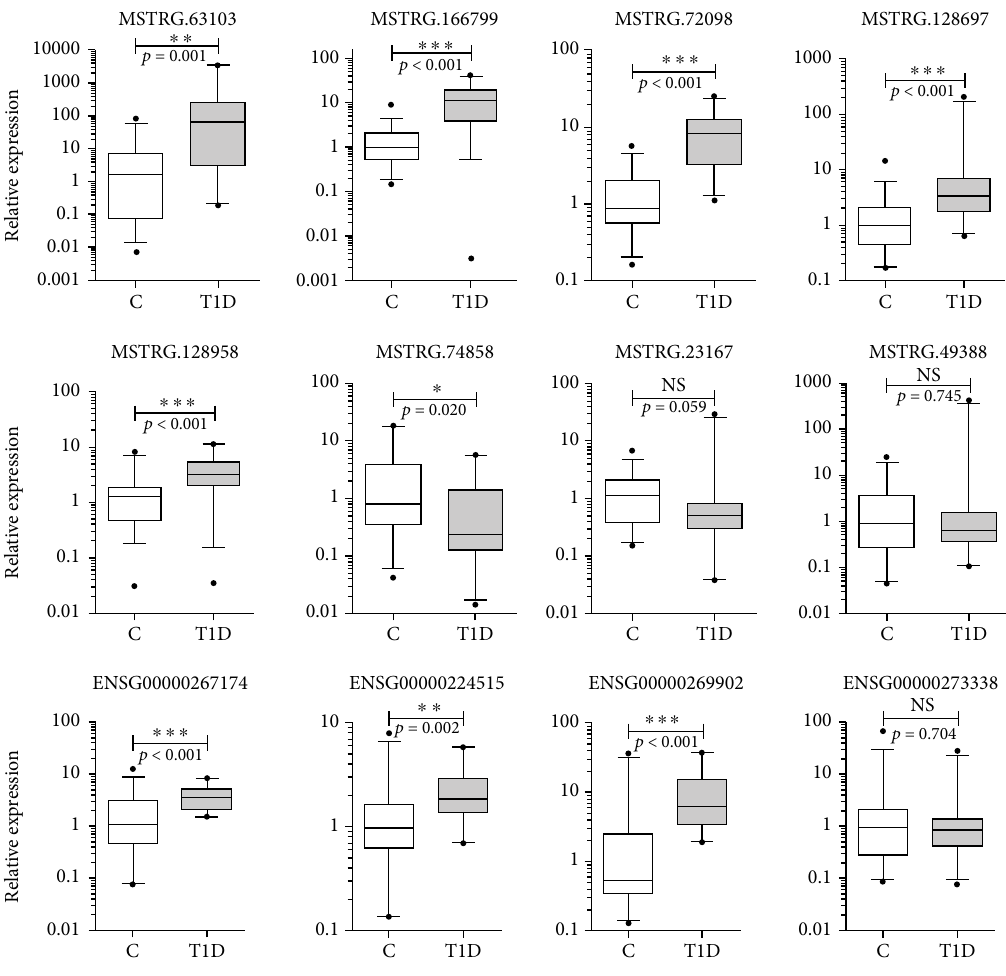
Figure 6: Results of 12 lncRNAs con fi rmed in the validation cohort by qPCR. There are 9 lncRNAs that showed signi fi cant di ff erences in expression levels between T1D patients ( n = 23 ) and healthy controls ( n = 36 ). NS: no signi fi cant di ff erence. ∗ indicates signi fi cant di ff erence with p < 0 : 05 and ∗∗ indicates p < 0 : 01